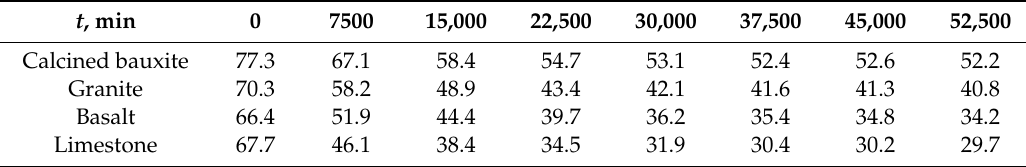
Table 6. PSV test results used to validate the